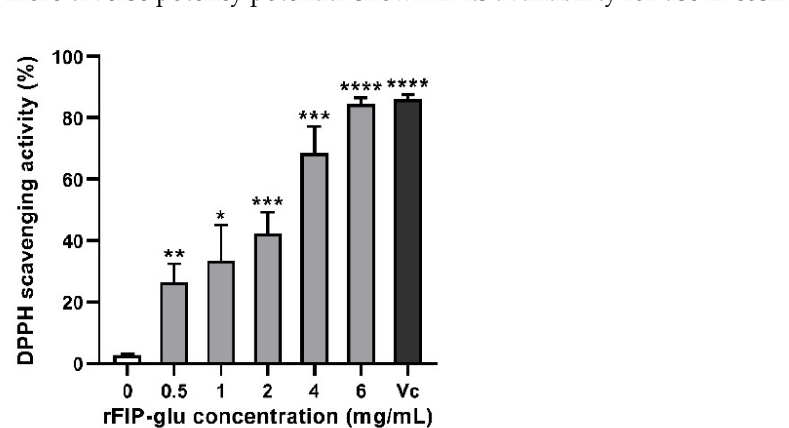
Figure 4. The effect of rFIP-glu on the scavenging rate of DPPH radicals. Vc (0.5 mg/mL) was used as the positive control. Data are expressed as means ± SD (n = 3). p > 0.05; *, p ≤ 0.05; **, p ≤ 0.01; ***, p ≤ 0.001; ****, p ≤ 0.0001 versus the control group.